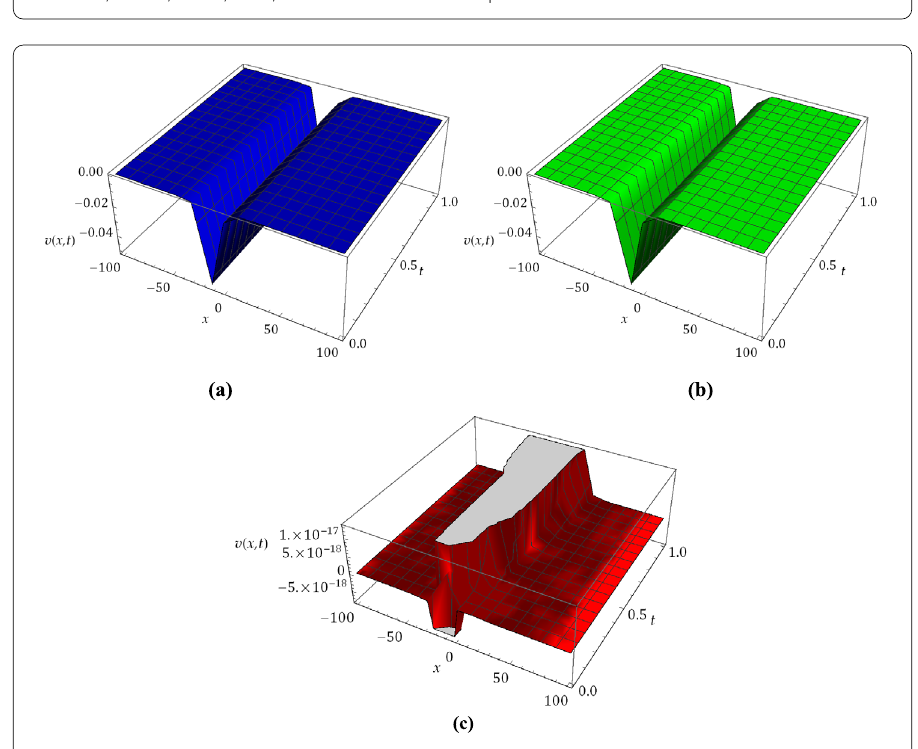
Figure 11 Behaviour of ( a ) Approximate solution ( b ) Exact solution ( c ) Absolute error = | v exa . – v app . | at ω = 0.005, (cid:13) = 0.1, c = 10, n = 1, α = 1 and (cid:2) = –1 for Example